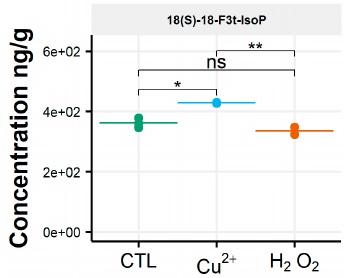
Figure 5. Changes in content of selected isoprostanoids for the diatom Chaetoceros gracilis between the control condition (CTL) and oxidative stress (Cu 2+ and H 2 O 2 ) conditions. Statistically relevant responses between the control and stress conditions (one-way ANOVA) are indicated by asterisks: * p < 5 × 10 − 2 and ** p < 5 × 10 − 3 ; ns, not significant.